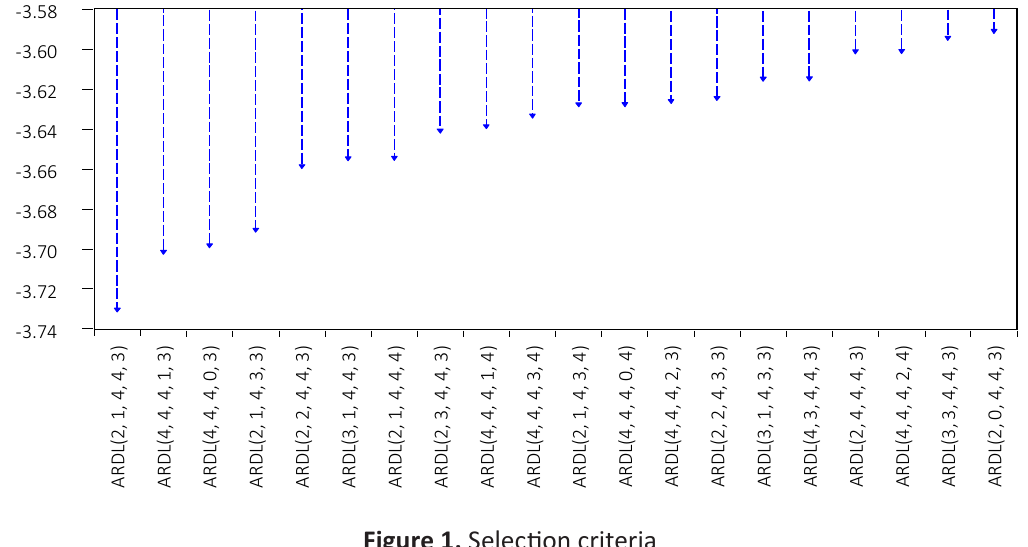
Figure 1. Selection Table 3. Bound test results